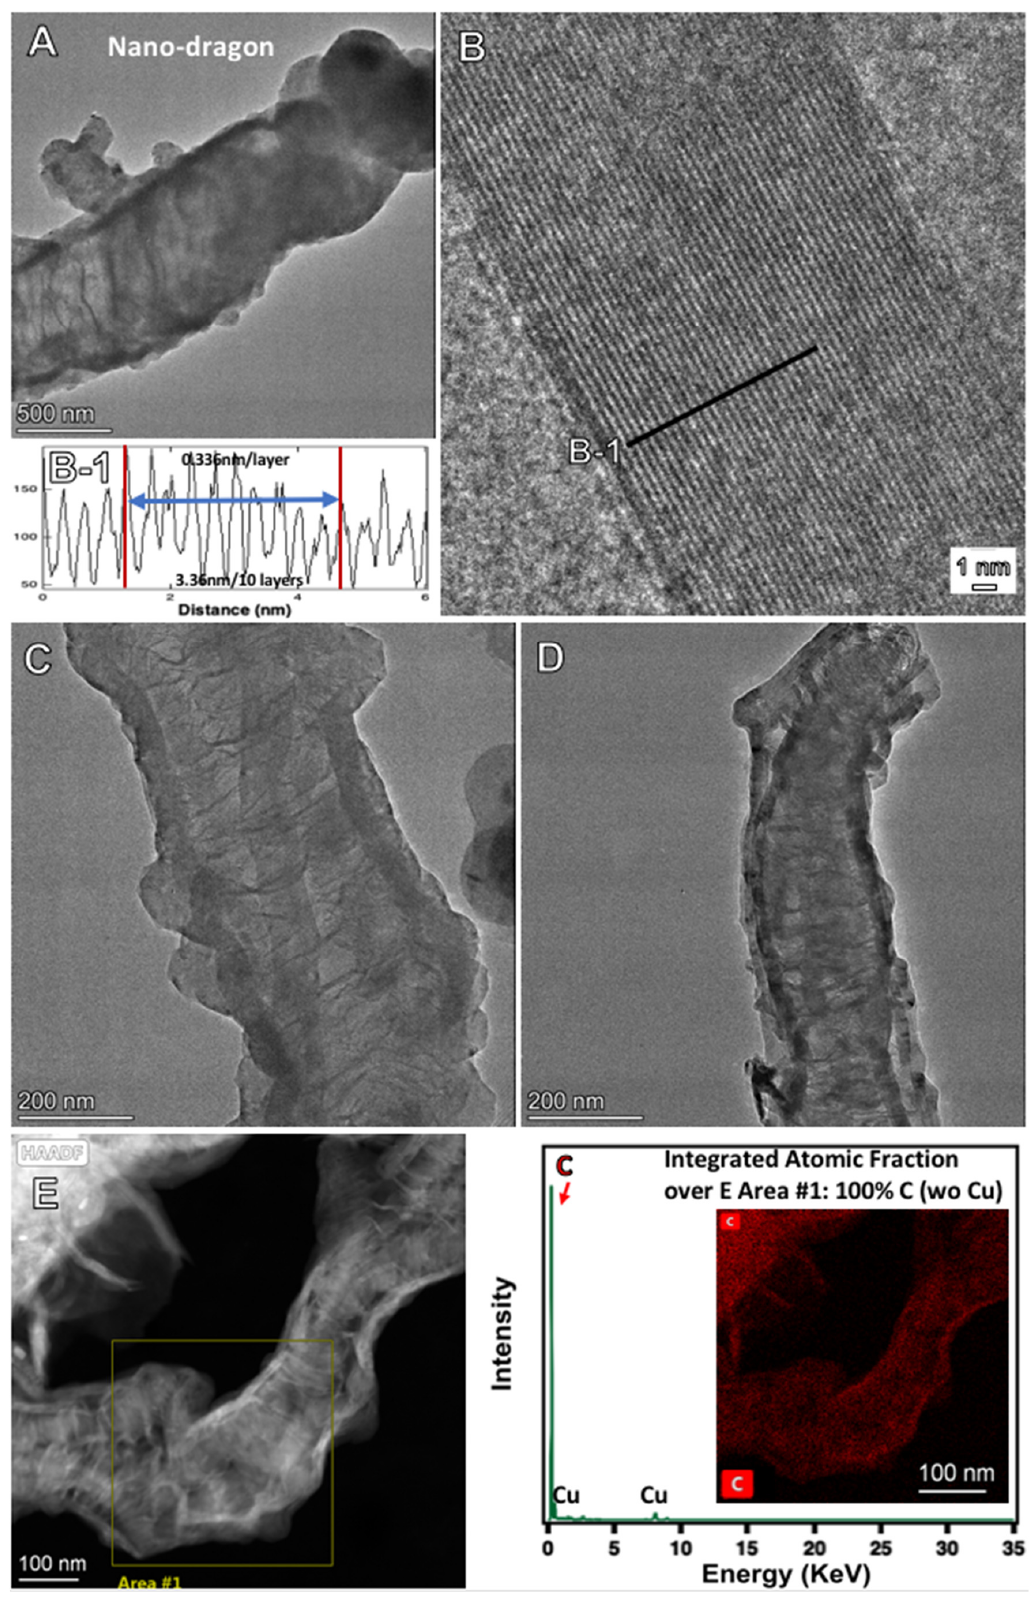
Figure 9. TEM and HAADF elemental analysis of the nano-dragons carbon allotrope synthesized by molten carbonate electrolysis. ( A , C , D ): Nano-dragon; ( B ) and B-1: Nano-dragon wall and measured graphene layer thickness ( E ); Nano-drageon and (right side) elemental